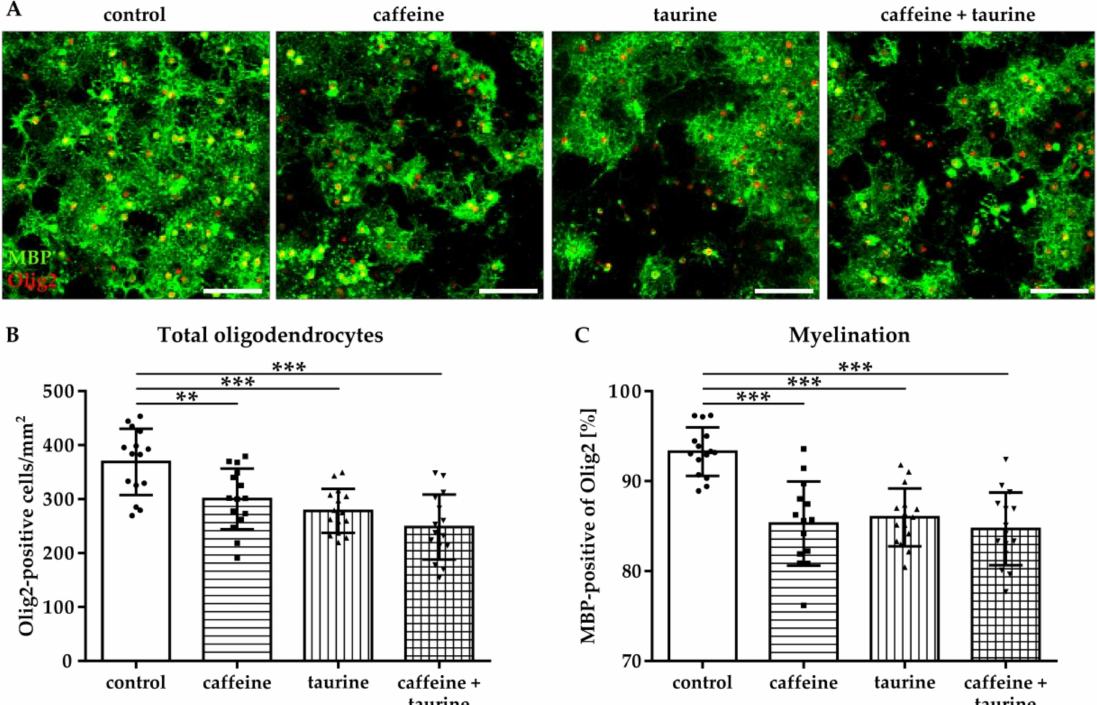
Figure 3. Myelination capacity of immature oligodendrocytes is decreased by ca ff eine and taurine. Primary immature oligodendrocytes were treated with or without 0.3 mg / mL ca ff eine, 4 mg / mL taurine, andthecombinationofbothfor24hfollowedbymediaexchangetodi ff erentiatingconditionsforanother three days. ( A ) Representative images of immunofluorescence staining for the pan-oligodendrocyte marker Olig2 (red) and the myelination marker MBP (green) to visualize mature oligodendrocytes. The density of oligodendrocytes was quantified by counting Olig2 positive cells ( B ). MBP-positive oligodendrocytes were quantified by subtracting MBP-negative cells from the total Olig2-positive cell number. ( C ). Data are derived from 15 images per group out of three independent experiments, depicted by circle = control, square = ca ff eine, triangle up = taurine, triangle down = ca ff eine + taurine. Scale bar 400 µ m. ** p < 0.01, *** p < 0.001, one-way ANOVA followed by a Bonferroni post hoc test.